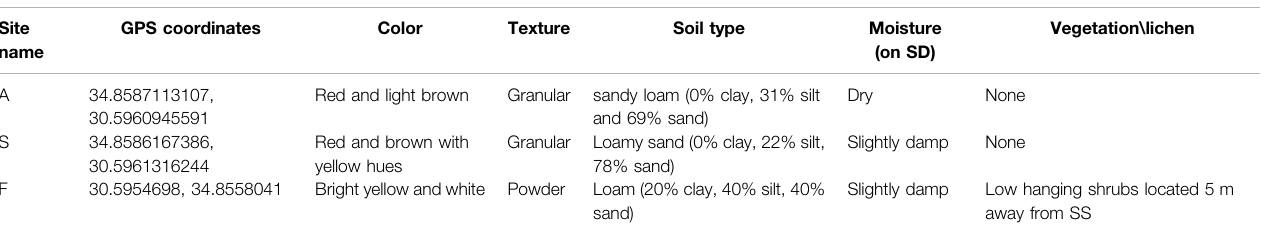
TABLE 1 | Site descriptions for soil samples. SD-sampling day, SS-sampling